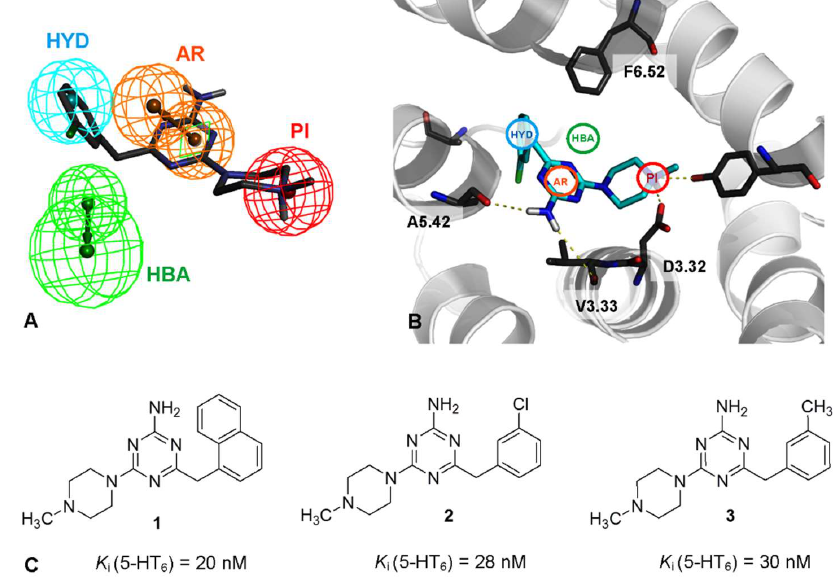
Figure 1. Modified pharmacophore model based of the 1,3,5-triazine with mapped compound 2 , including four key pharmacophore features, namely: A positive ionizable group (PI, red), an aromatic ring (AR, orange), a hydrogen bond acceptor group (HBA, green) and hydrophobic group (HYD, blue) ( A ). The lead compound 2 mapped onto the binding site of 5-HT 6 R ( B ). Examples of the most active 1,3,5-traizne 5-HT 6 ligands found recently 1 – 3 ( C ).